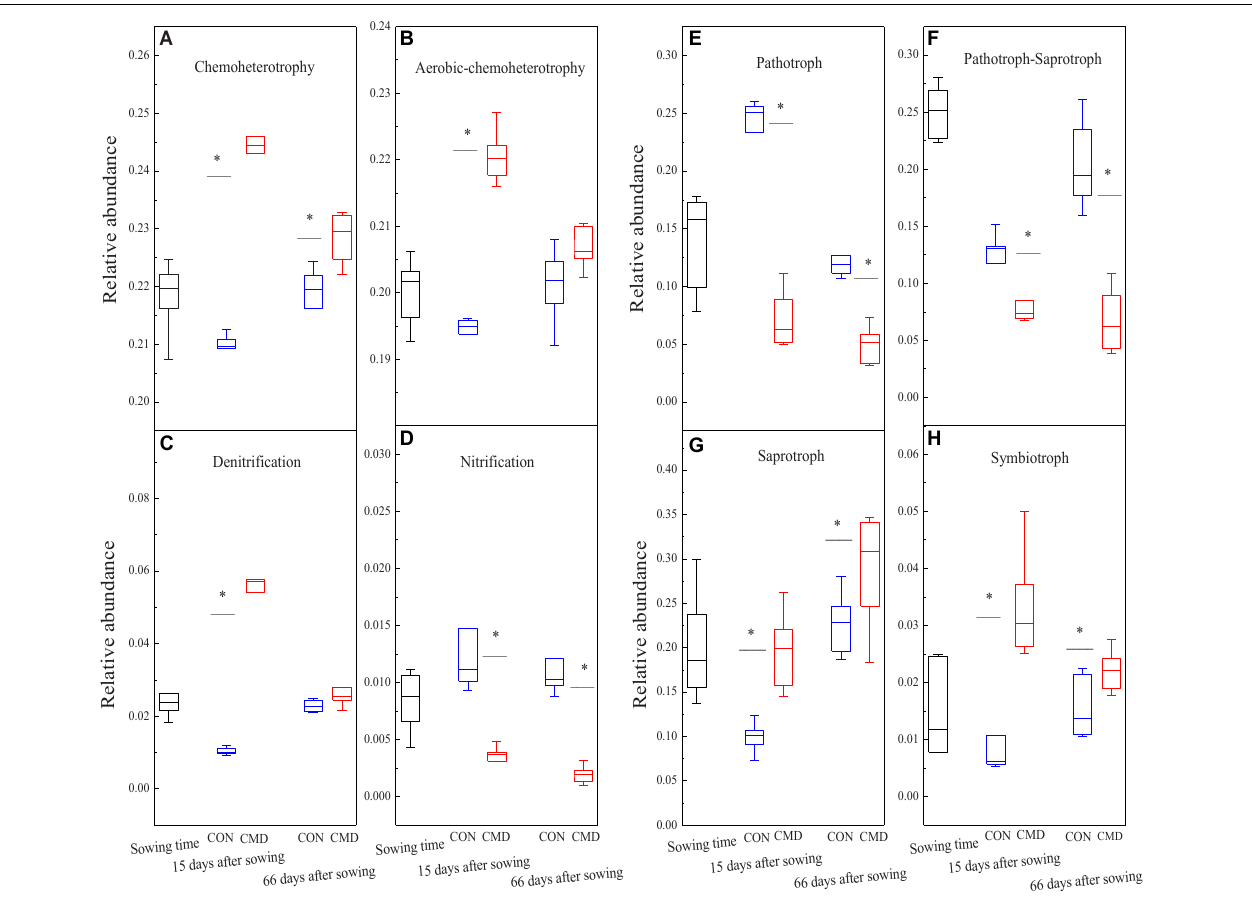
FIGURE 6 | Bacterial (A–D) and fungal (E–H) functional groups based on FAPROTAX database and FUNguild database, respectively under CON and CMD treatments at different growth stages. CON, control; CMD, cattle manure deposition. 0 days corresponds to sowing date; 15 days after sowing corresponds to plant trefoil stage; 66 days after sowing corresponds pustulation stage. CON, control; CMD, cattle manure deposition. Data represents mean ± SE (n = 3). The data was based on a pot experiment in one year. All parameters were analyzed with SPSS version 16.0 (SPSS Inc. Chicago, IL, United States). Asterisk, on bar represent differences ( P < 0.05) between CON and CMD treatments for each microbial functional group at each growth stage.